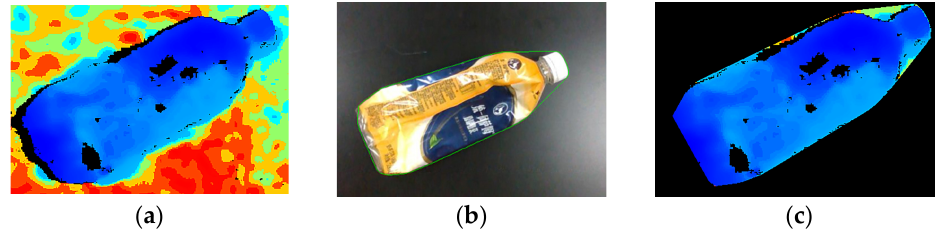
Figure 15. The processing of depth map: ( a ) convex hull; ( b ) mask; ( c ) image mask.